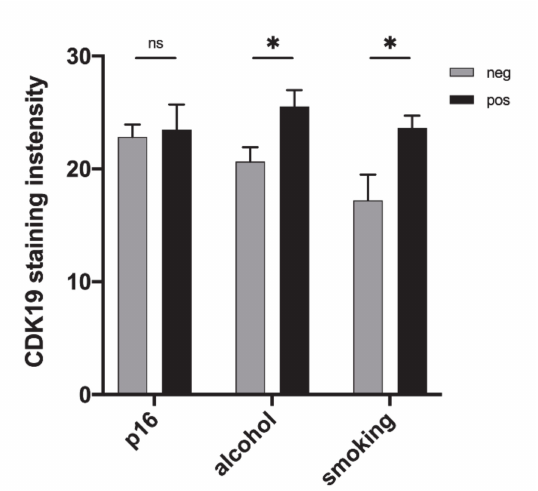
Figure 4. CDK19 expression correlates with clinicopathological data. Bar graphs show higher CDK19 expression in smokers and HNSCC patients with heavy alcohol consumption (arbitrary units).